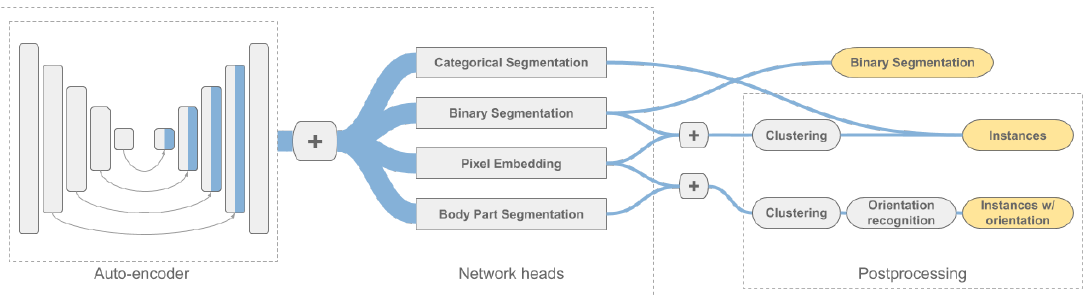
Figure 3. Schematic representation of the proposed framework. The auto-encoder is an U-Net architecture (depiction adopted from [44]). The individual stages consist of several blocks, each with several layers. Scaling down or up is done between the stages. Skip connections are used to combine the results of the encoder and decoder stages. The network is equipped with different heads for the different experiments. The output is processed afterwards to yield the desired